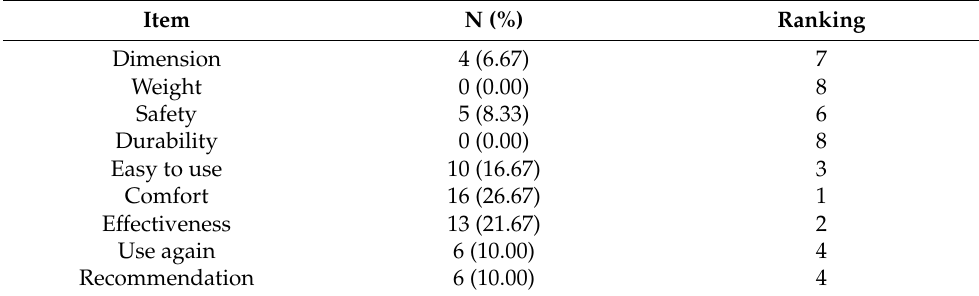
Table 9. WAD factor